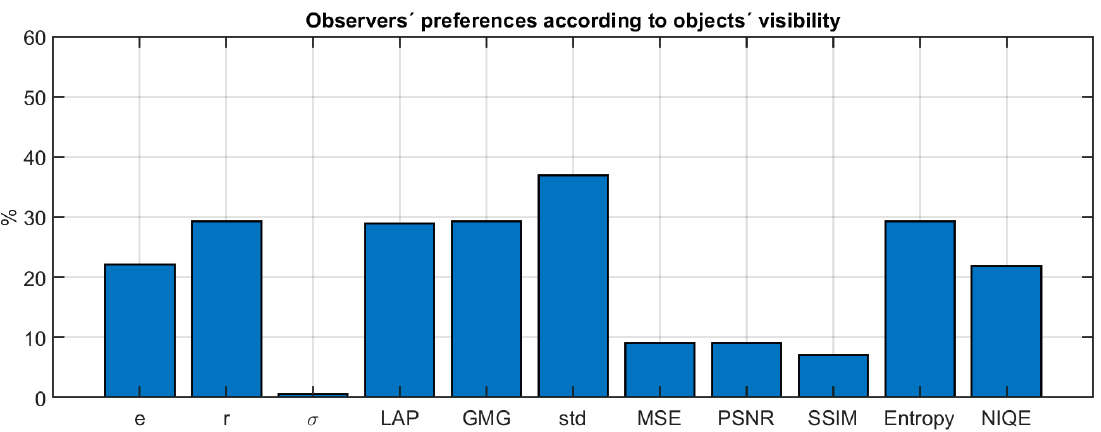
Figure 11. Percentage of agreement between the observers’ answers to question 2 of the survey and the different metrics analyzed.